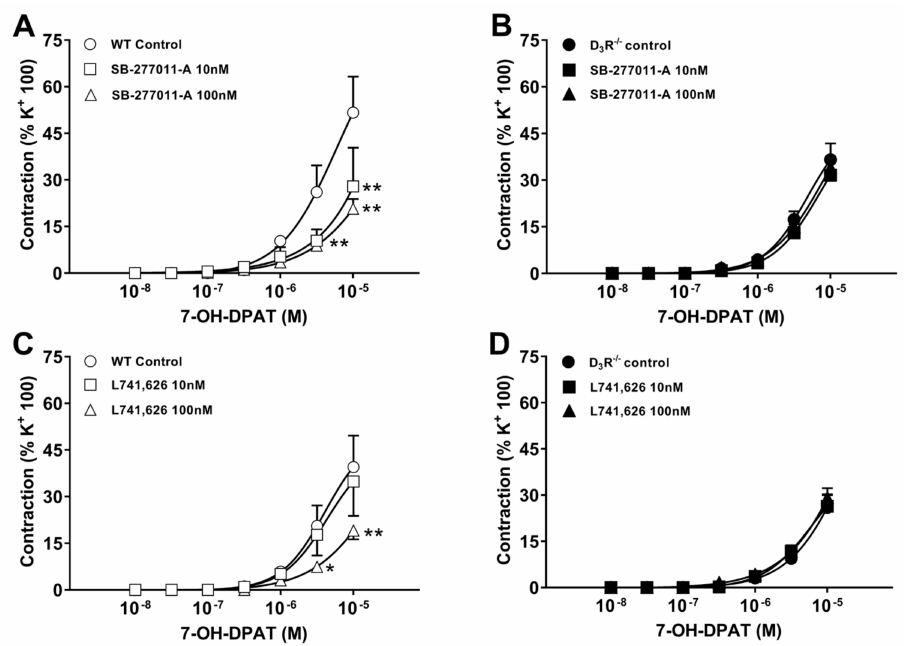
Figure 3. Effect of dopamine receptor antagonists on 7-hydroxy-2-dipropylaminotetralin (7-OH- DPAT)-induced vasoconstriction, in aortic segments isolated from wild-type (WT, A , C ) and D3R − / − mice ( B , D ). ( A , B ) Effect of the D3R antagonist SB-277011-A; ( C , D ) effect of the D2R antagonist L741,626. Each curve (with vertical bars representing standard errors) represents the average from 8–10 preparations. Two-way ANOVA, Panel A (antagonist conc.: F (2,84) = 7.23, p = 0.0013; agonist conc.: F (6,84) = 26.41, p < 0.0001; antagonist conc. x agonist conc. F (12,84) = 2.50, p = 0.0076); Panel C (antagonist conc.: F (2,105) = 3.53, p = 0.033; agonist conc.: F (6,105) = 26.80, p < 0.0001; antagonist conc. × agonist conc. F (12,105) = 1.16, p = 0.3163) and Bonferroni’s test (* p < 0.05, ** p < 0.01 vs.